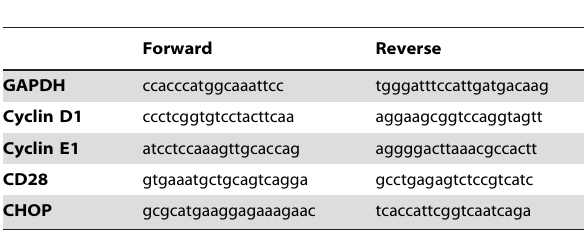
Table 2. Primers used for real time PCR